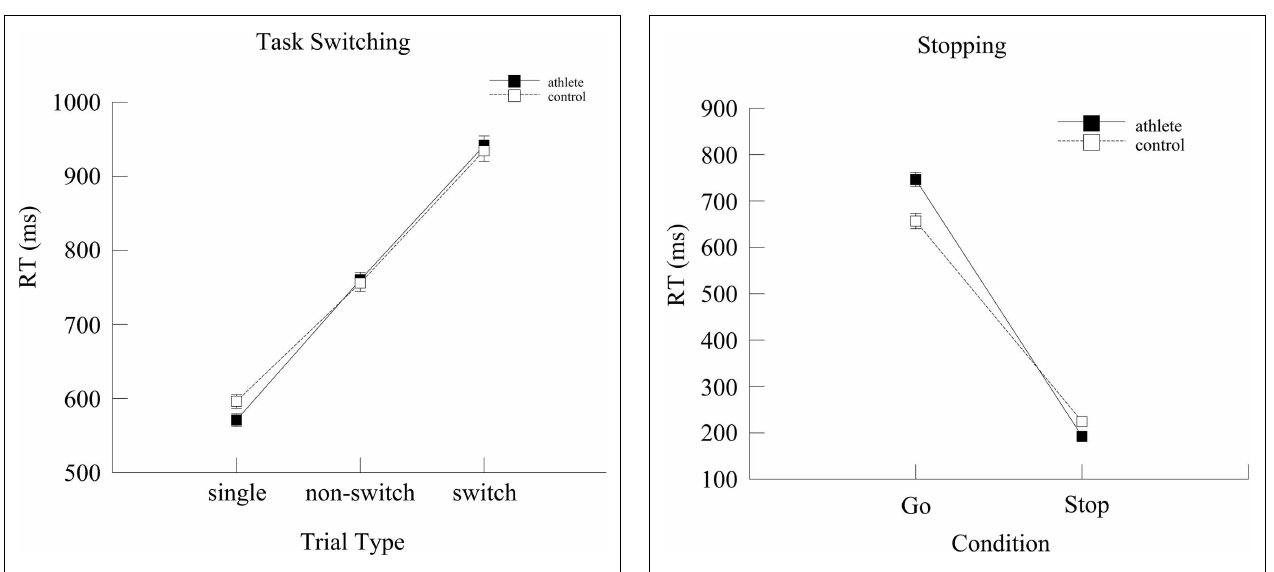
FIGURE 2 | Mean reaction time (ms) for the two groups on the Go and Stop conditions. Error bars represent ± 1 standard error.